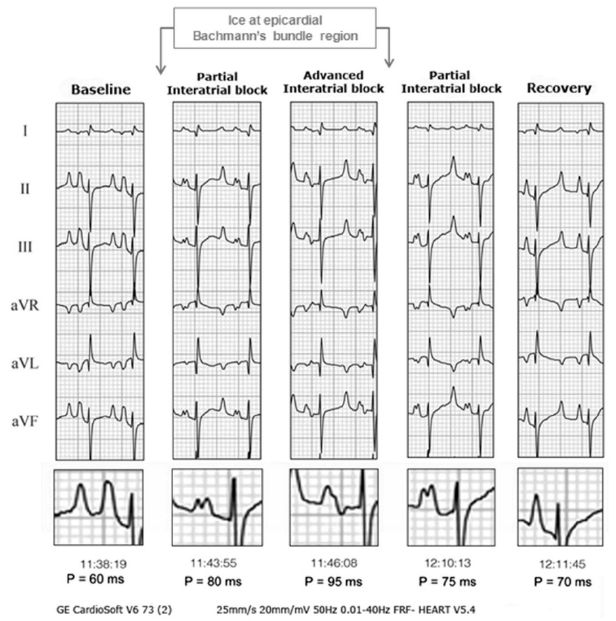
Figure 2. Transient changes of P-wave recorded in lead II after applying ice to the Bachmann’s region. Surface electrocardiogram (ECG) of an open-chest anesthetized healthy adult swine, before, during, and after direct application of ice at the transversus sinus of the pericardium (Bachmann’s region). A change in P-wave duration and morphology, constituting a transient interatrial block (IAB), is observed as rapidly evolving from partial to advanced IAB (A-IAB). Subsequently, as the ice melts, the ECG pattern normalizes. Please note that P-wave duration in pigs is different (shorter) than in humans. (Taken from reference 22).